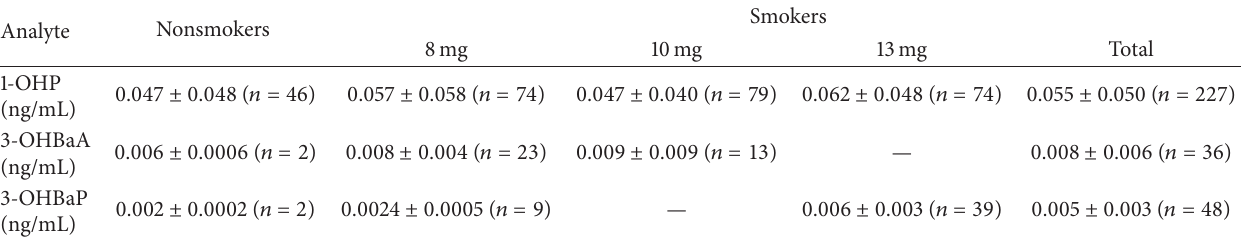
Table 3: Urinary 1-OHP, 3-OHBaP, and 3-OHBaA concentration after removing abnormal value.